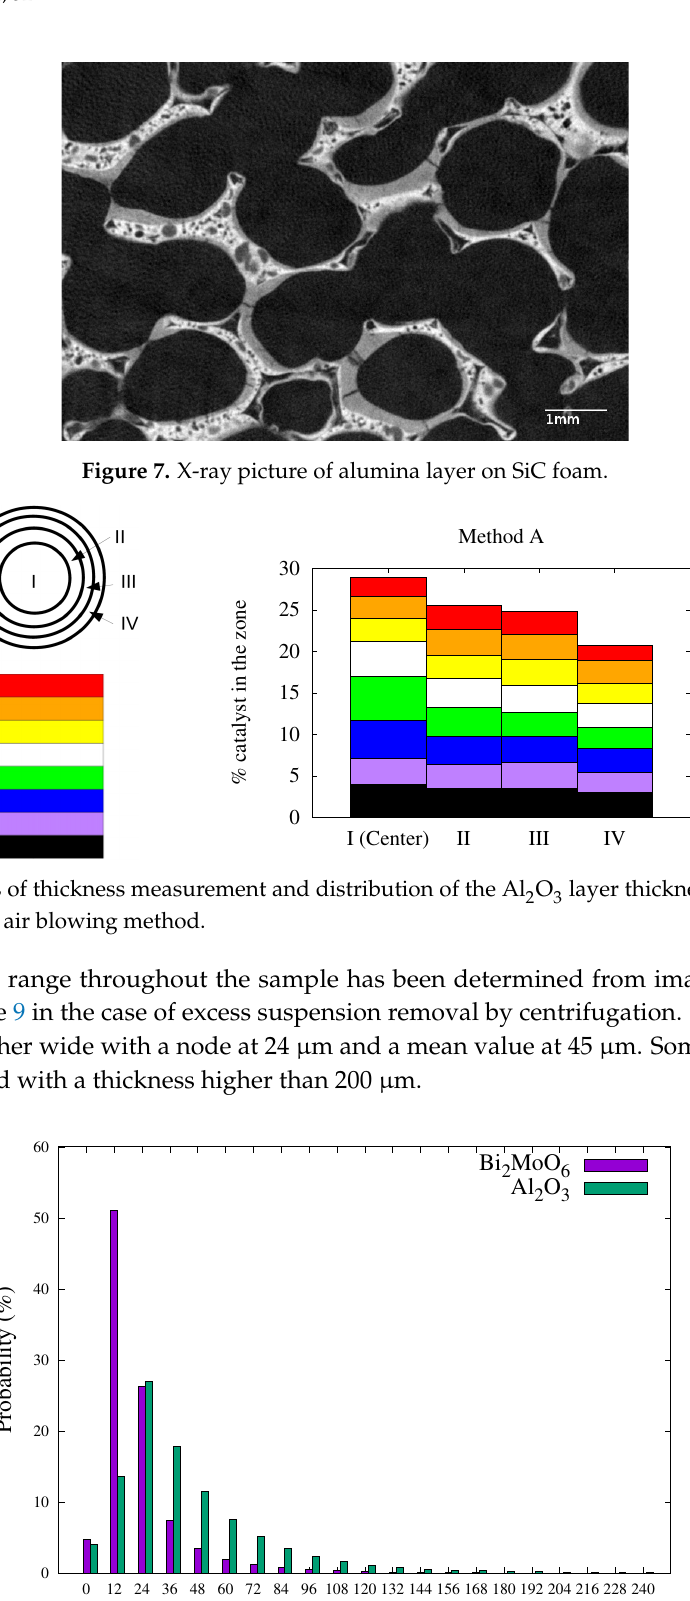
O /SiC foam and Bi 2 3